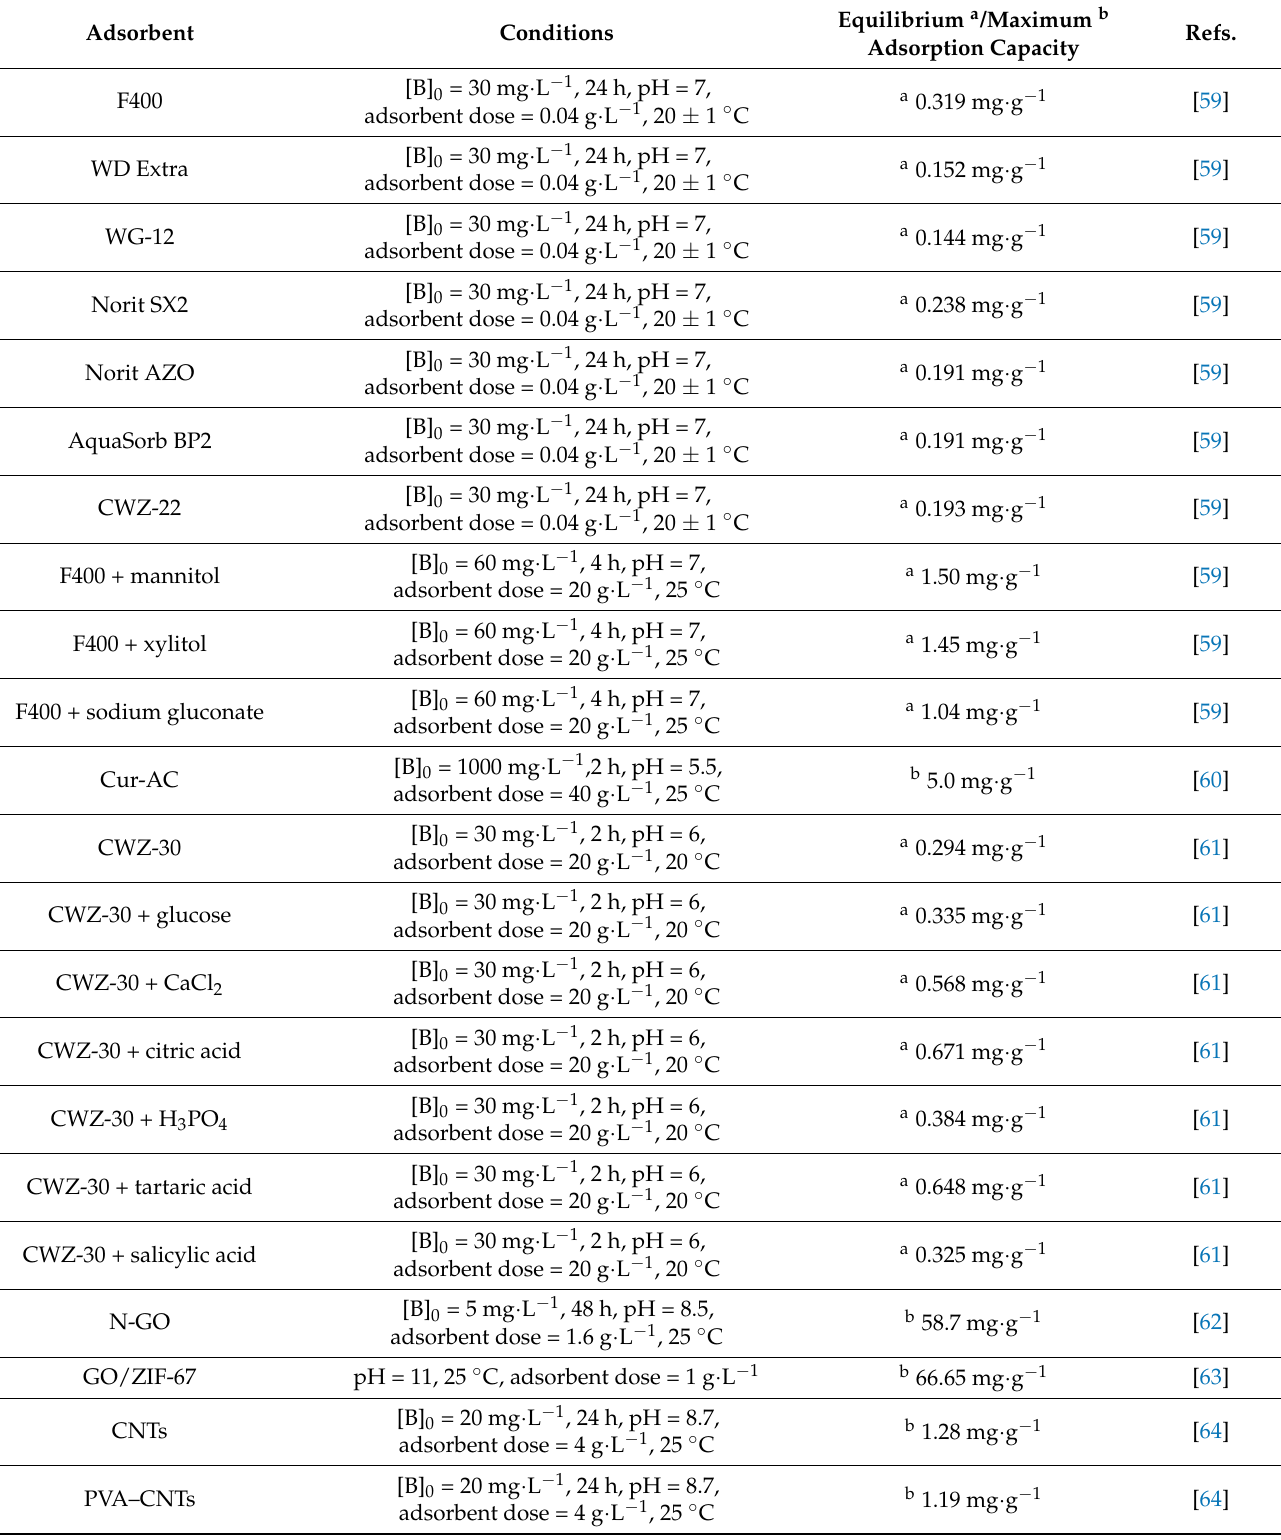
Table 7. Boron adsorption performances of different carbon-based materials